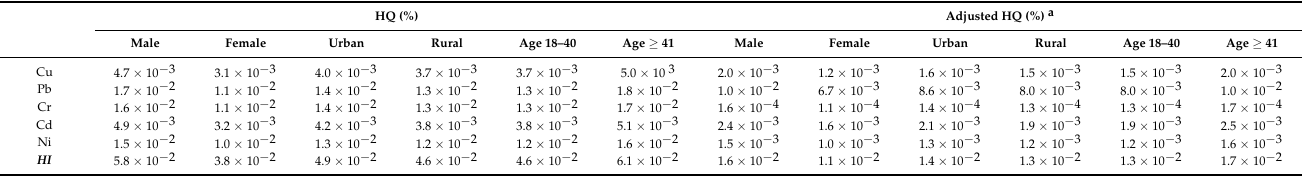
Table 5. Non-carcinogenic hazard quotient of heavy metals due to tea infusion consumption.